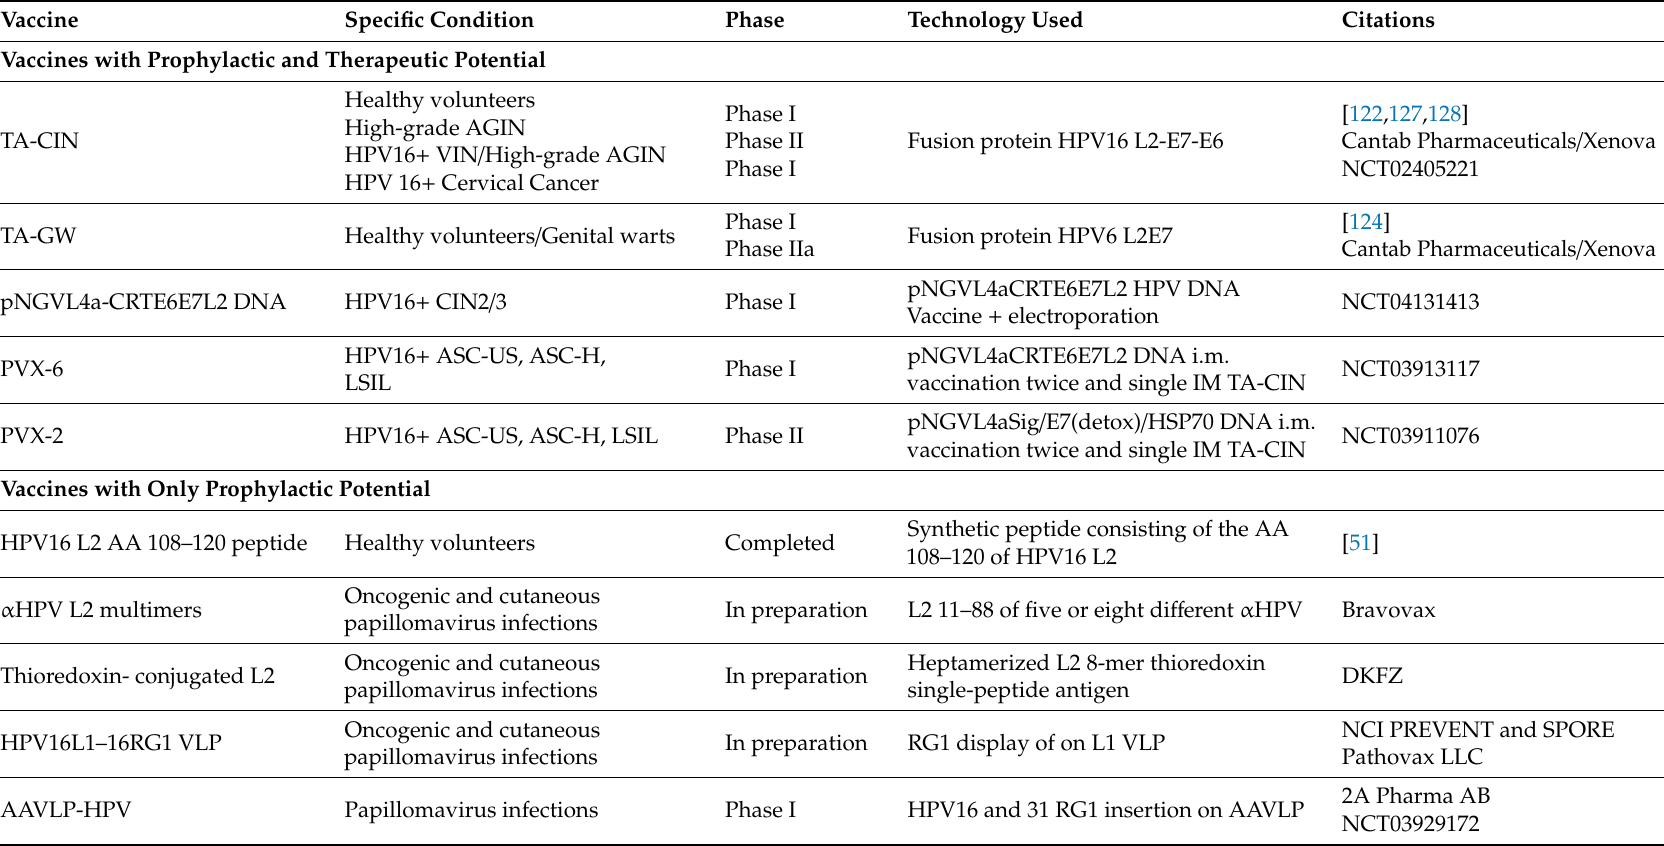
Table 2. Summary of clinical studies testing vaccines that include the minor capsid protein